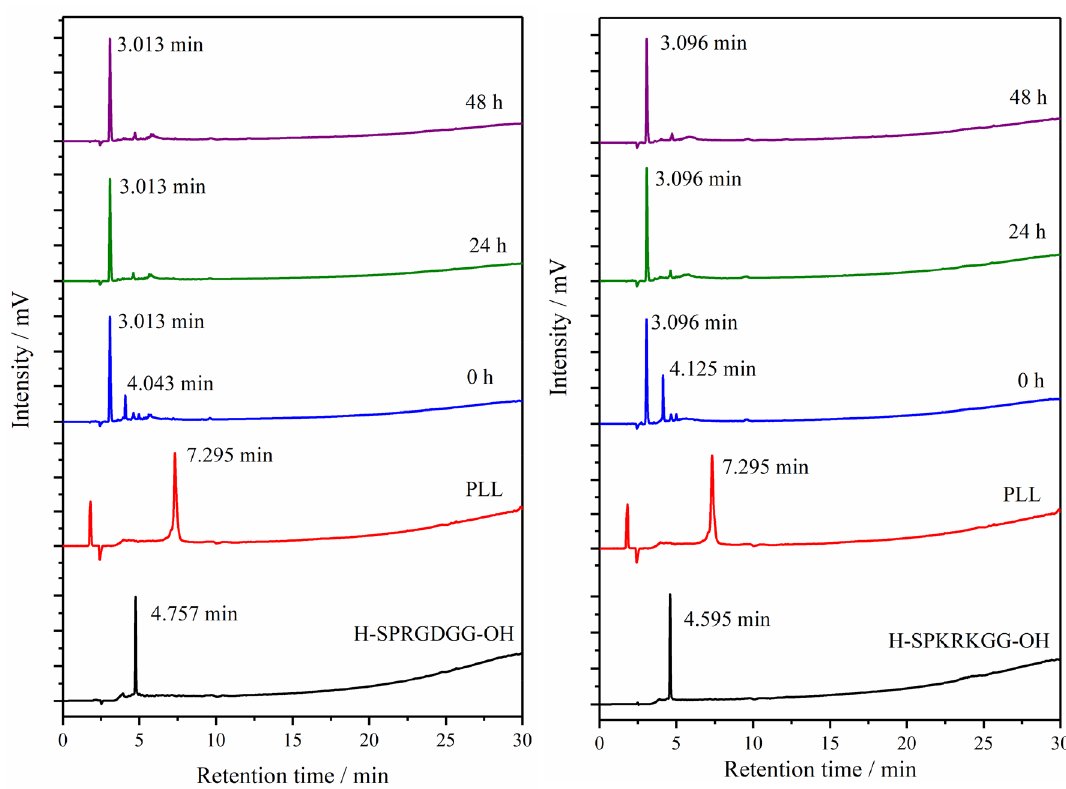
Figure 3. Covalent bioconjugation of PLL linker with RGD and KRK peptide reaction progress monitored by Reversed Phase High Performance Liquid Chromatography. RP-HPLC conditions: HPLC Shimadzu system (Shimadzu Prominence-i LC-2030C) with Cosmosil C18 column (4.60 mm × 250 mm, 90 Å, 5 µm) using linear gradient method from 0 to 100% solvent B for 30 min at flow rate of 1.50 mL min −1 with UV detection at λ 1 = 224 nm and λ 2 = 254